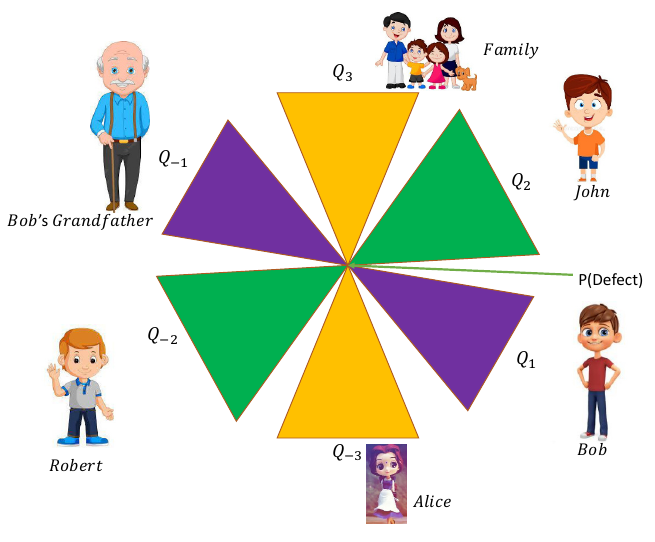
Figure 10 . Different universes Q − 1 , − 2 , − 3 , 1 , 2 , 3 where different people are